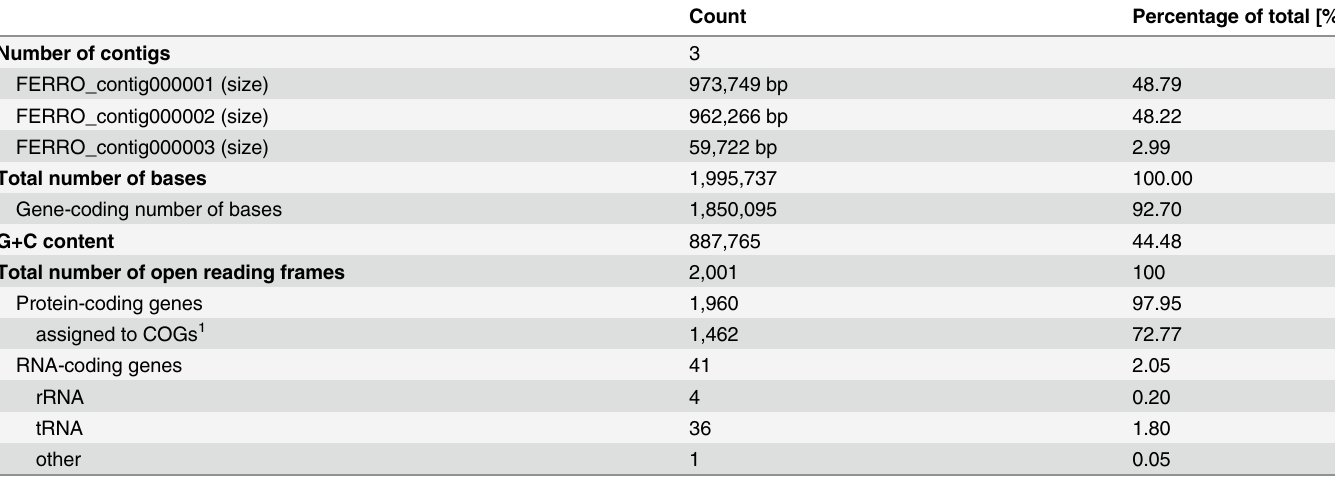
1 Number and percentage of protein-coding genes assigned to the COG categories are shown in S1